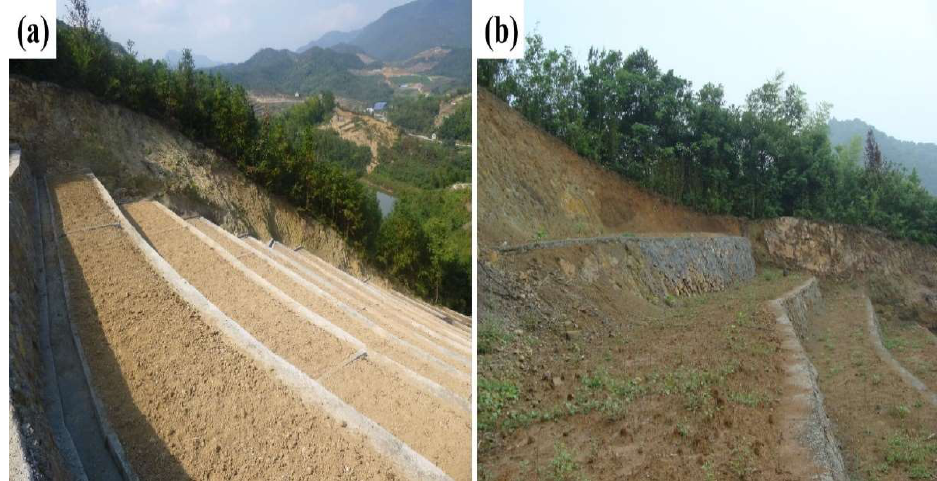
Figure 1. Soil improvement ( a ) in the newly reclaimed land ( b ) in Hangzhou. The soil of the new reclamation land is a green-purple mud field with silty clay